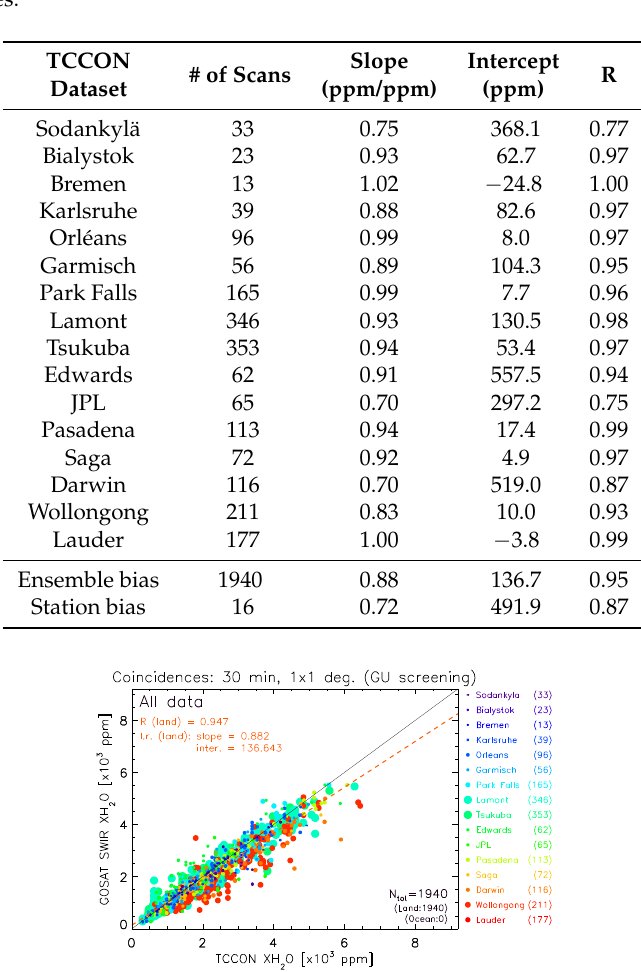
Table 3. Correction of Table 3 in [1]. Linear regression parameters (slope and intercept) and correlation coefficient (R) for TANSO-FTS scans acquired over land within ± 1 ◦ in latitude and in longitude of the TCCON sites and the average of TCCON measurements within ± 30 min of the corresponding GOSAT overpasses.